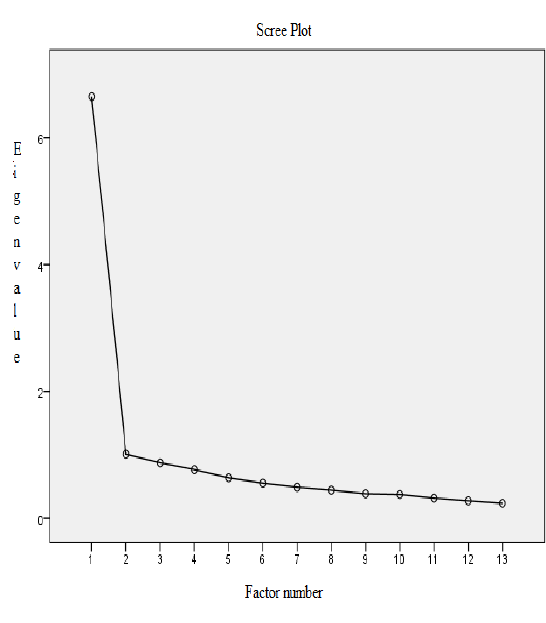
Figure 1. Scree plot for the EFMC-MOOC